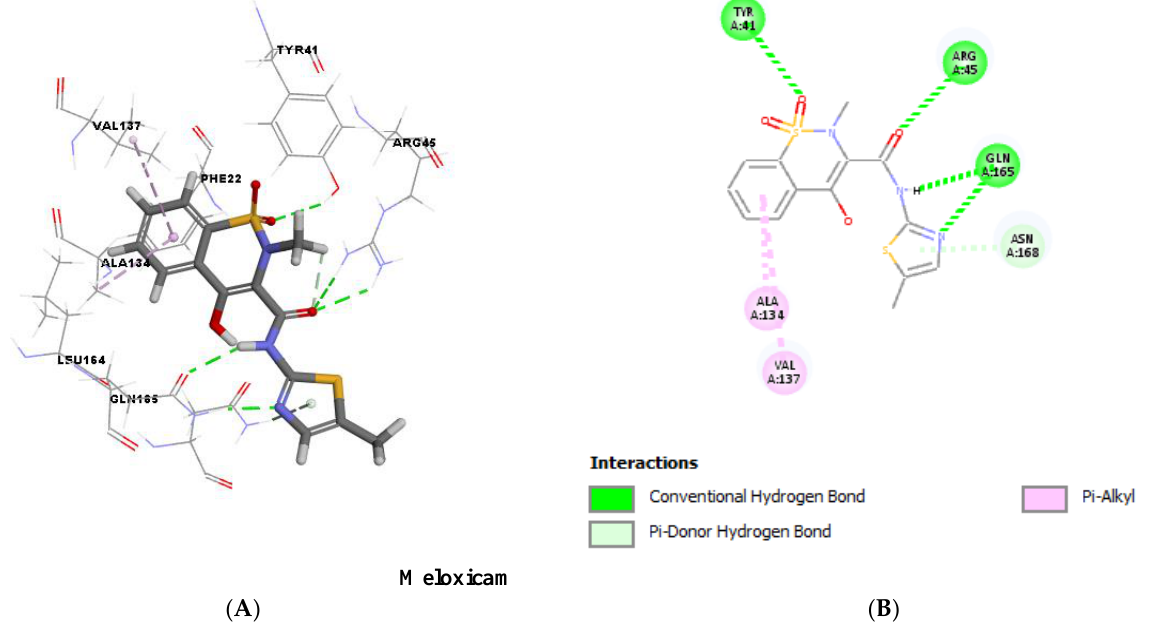
Figure 12. Molecular docking analysis showing (Three-dimensional) 3D ( A ) and (two-dimensional) 2D ( B ) representation of interaction patterns of MXM with CrtM receptor.